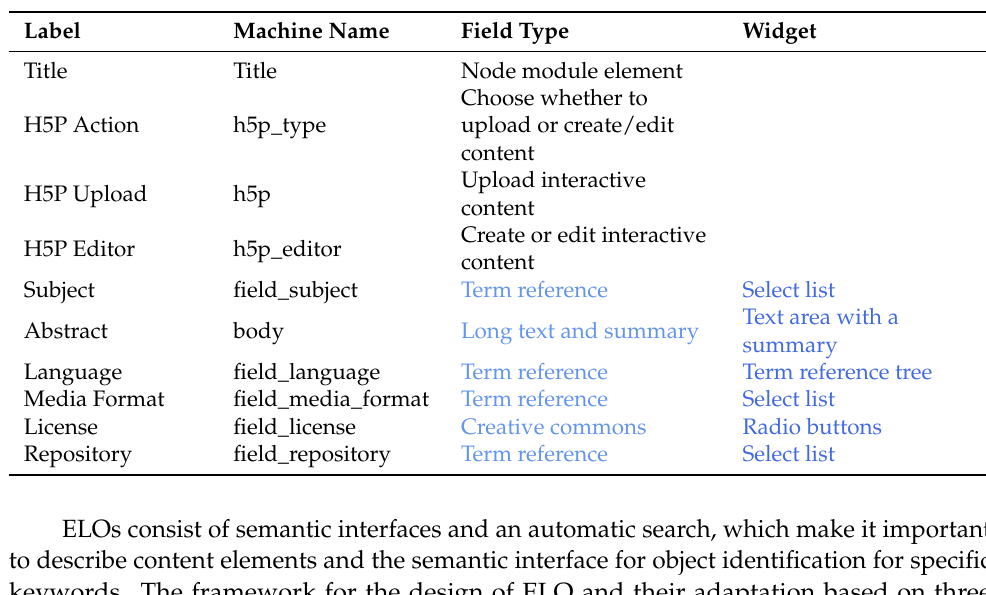
Table 1. Content types and a description.